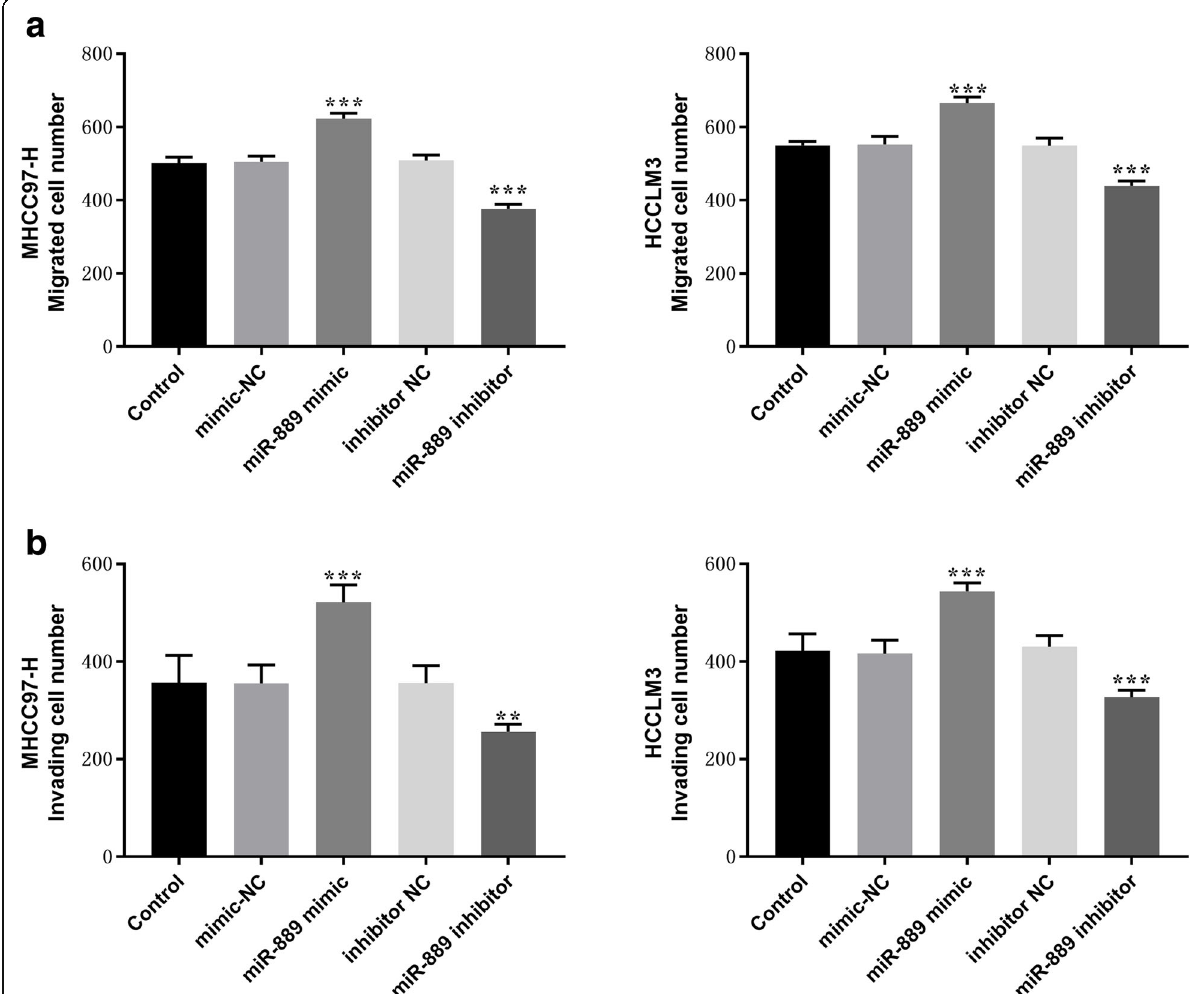
Fig. 4 Effects of miR-889 on cell migration and invasion abilities in MHCC97-H and HCCLM3 cells. ( a ) Cell migration and ( b ) invasion abilities were assessed with Transwell assay. ** P < 0.01, *** P <